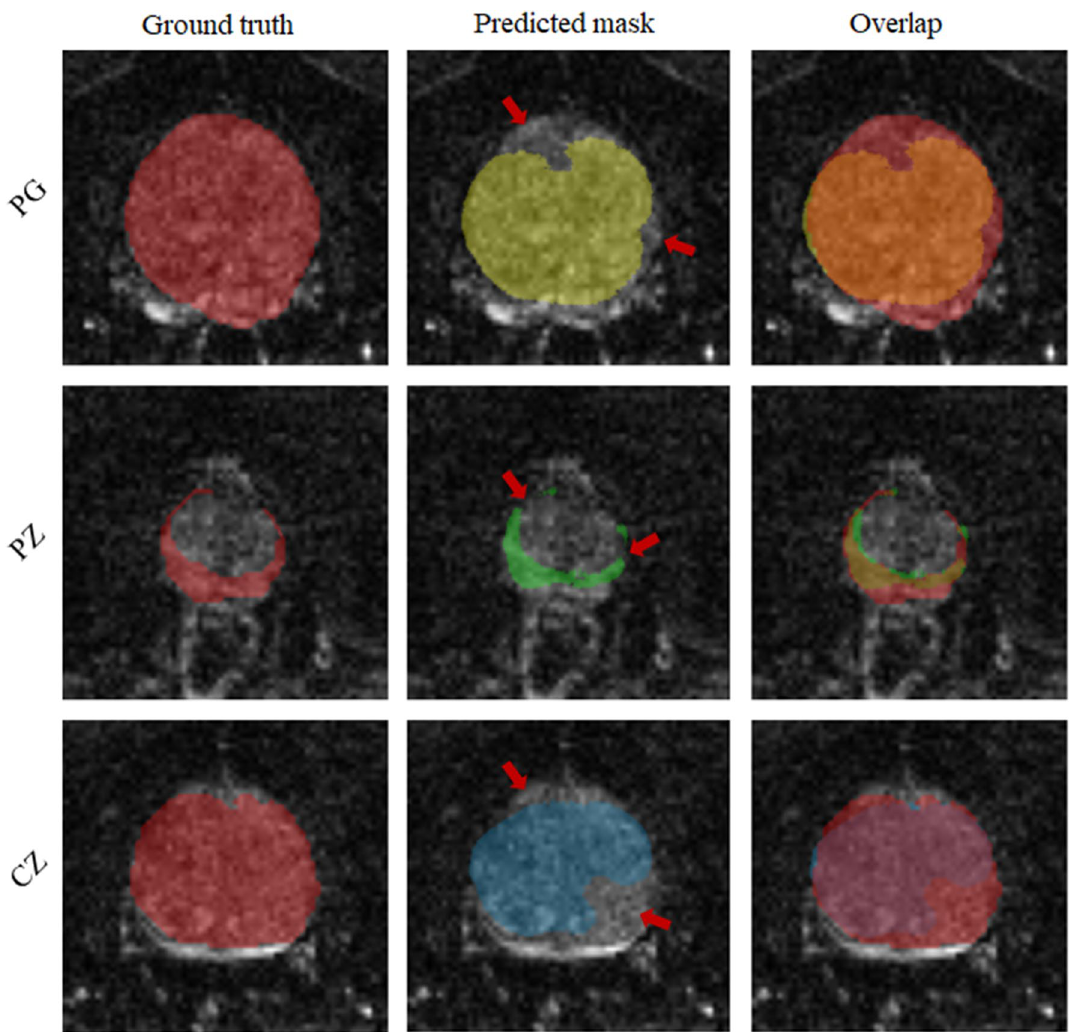
Figure 8. Illustration of inaccurate segmentations: left column is the ground truth; middle is predicted masks and right is the overlap between ground truth and predicted masks. Rows from top to bottom, images of PG, PZ and CZ respectively.